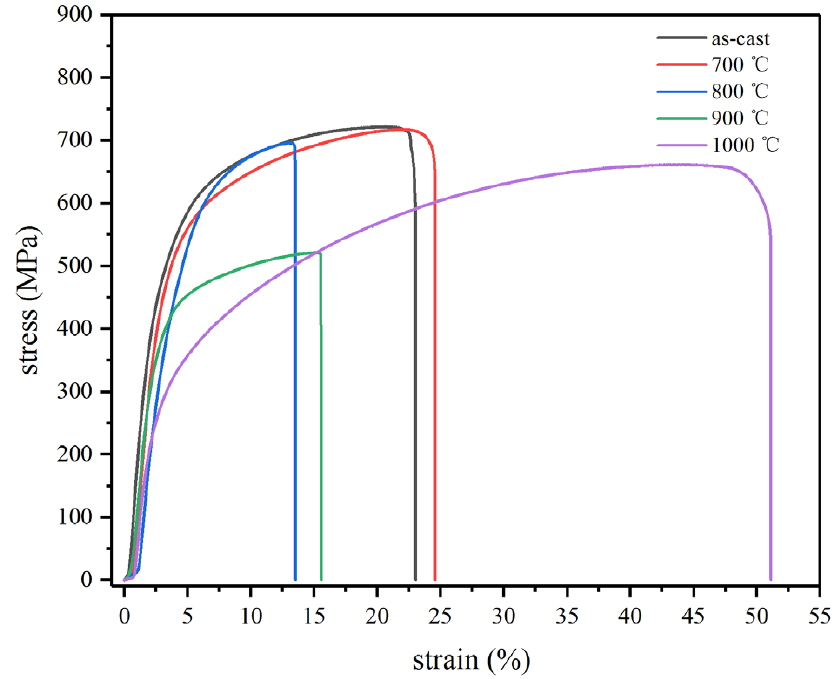
Figure 6. Tensile stress-strain curve of FeCrMnNi alloys. Table 3. Tensile properties of FeCrMnNi alloy heat-treated at different temperatures.